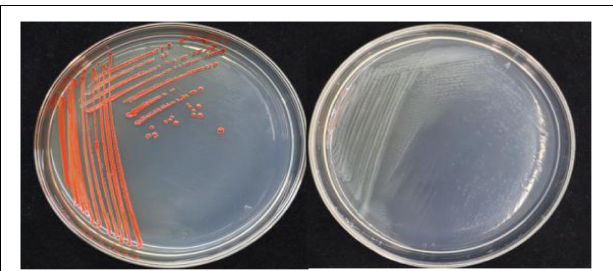
FIGURE 1 | Growth of strain QZB-2 on LB agar plates (left: supplied with 2 mM SeO 32 − ; left: no SeO 32 − ). The red colony color indicates selenite reduction and the formation of elemental selenium.